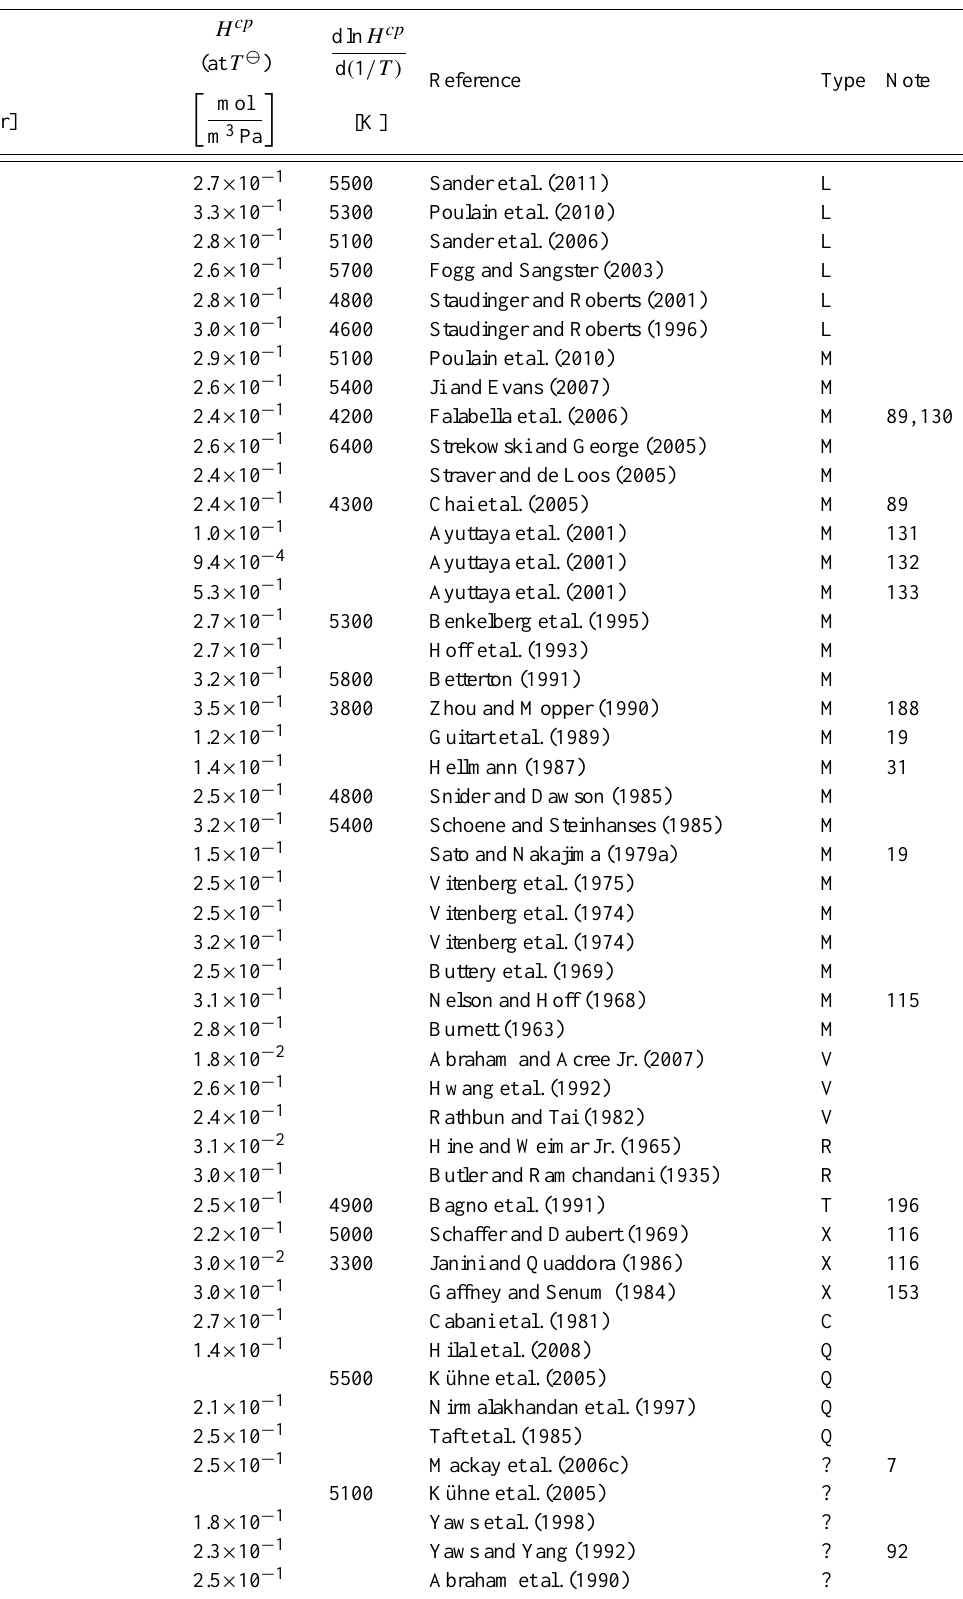
Table 6: Henry’s law constants for water as solvent